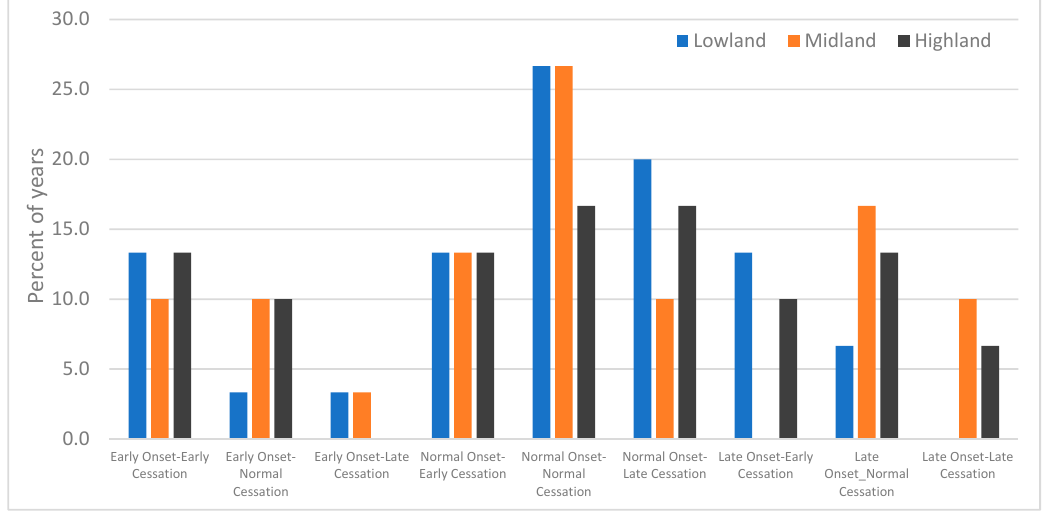
Figure 6. Distribution of time of onset and cessation of kiremt rainfall by agro-ecological settings.